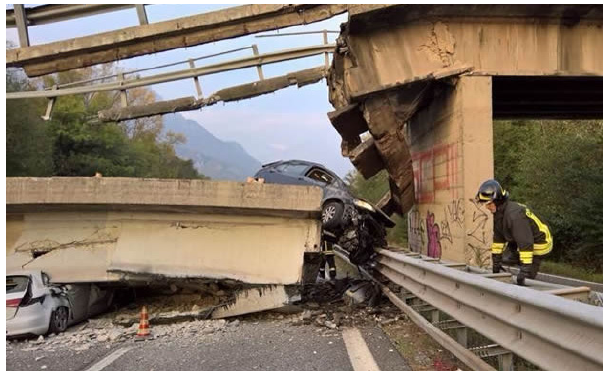
Figure 2. The Annone Brianza overpass collapse.